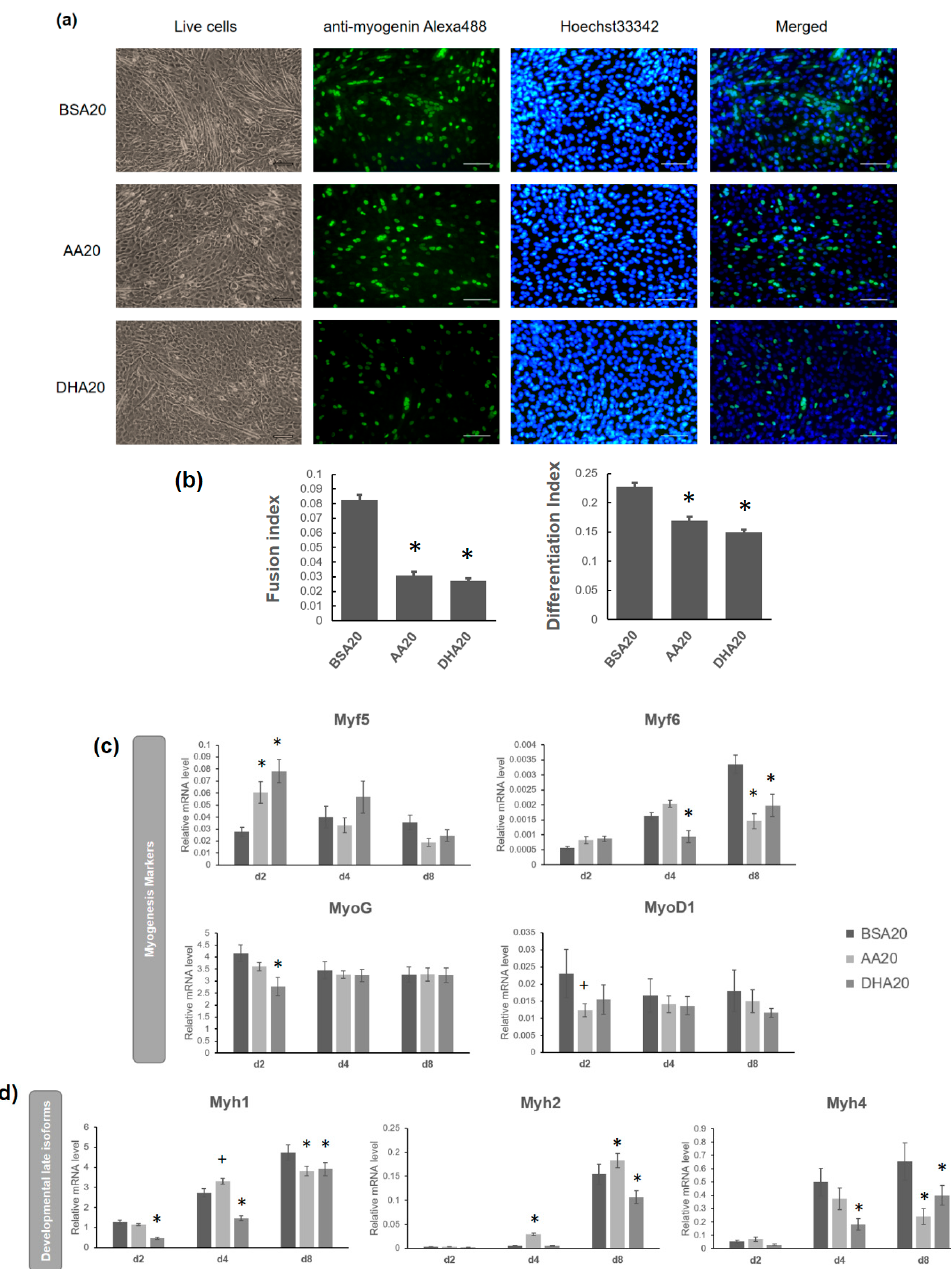
Figure 3. The effect of 20 μ M PUFA on C2C12 myotubes formation. ( a ) Immunofluorescence staining using Anti-Myogenin Alexa Fluor ® 488 and Hoechst 33342 staining on C2C12 myotubes at day 2 (d2) of the treatment. Scale bar for live cells is 100 μ m, Scale bar for anti-myogenin Alexa488, Hoechst 33342 staining and merged is 200 μ M. ( b ) Quantification of differentiation index and fusion index are shown. The mRNA level of myogenesis markers at three time points (d2 (2 days treatment), d4 (2 days treatment plus 2 days recovery), d8 (2 days treatment plus 6 days recovery)) was showed. ( c ) At d2, Myf5 expression level was induced in both AA20 and DHA20 treatments. MyoG expression level was significantly decreased in DHA20 treatment. MyoD1 expression level was decreased in AA20 treatment. The expression of Myf6 significantly decreased at d4 in DHA20, and significantly decreased in both AA20 and DHA20 at d8. ( d ) The expression levels of Myh1 significantly decreased at d2, d4 and d8 in DHA20 and in AA20 at d8. The expression levels of Myh2 significantly increased in d4 and d8 in AA20 and significantly decreased in DHA20 at d8. The expression levels of Myh4 significantly decreased at d4 in DHA20 and in both AA20 and DHA20 at d8. All values are LS means ± SEM, + indicate p < 0.1 and * indicates p < 0.05 treatment vs. control group